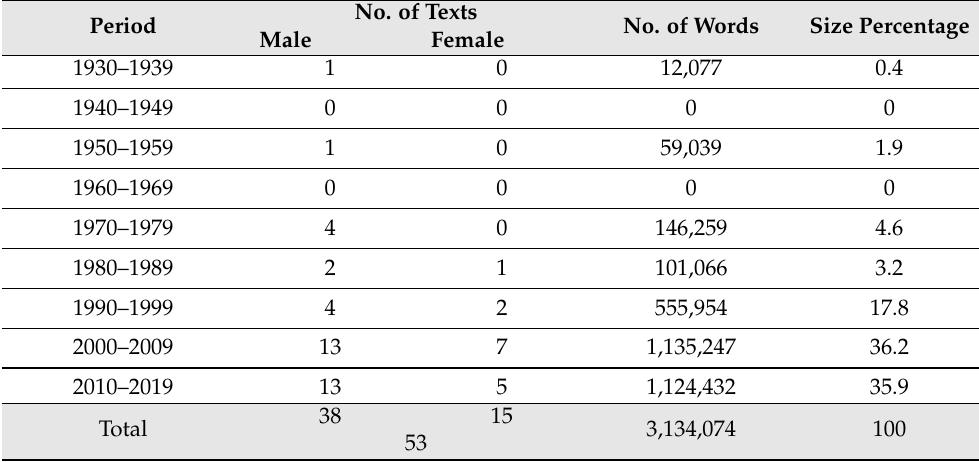
Table 2. Detailed statistics on the content of the corpus.